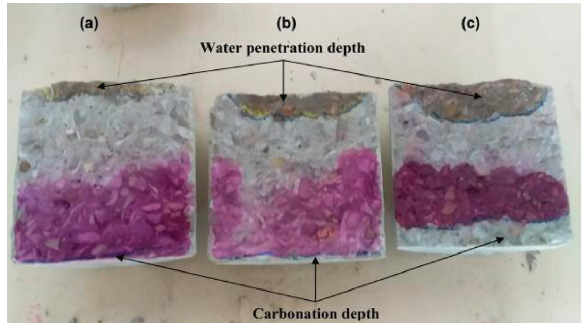
Figure 5: The measurement of carbonation penetration and water penetration depths: (a) SCCM; (b) SCCL; (c) ordinary